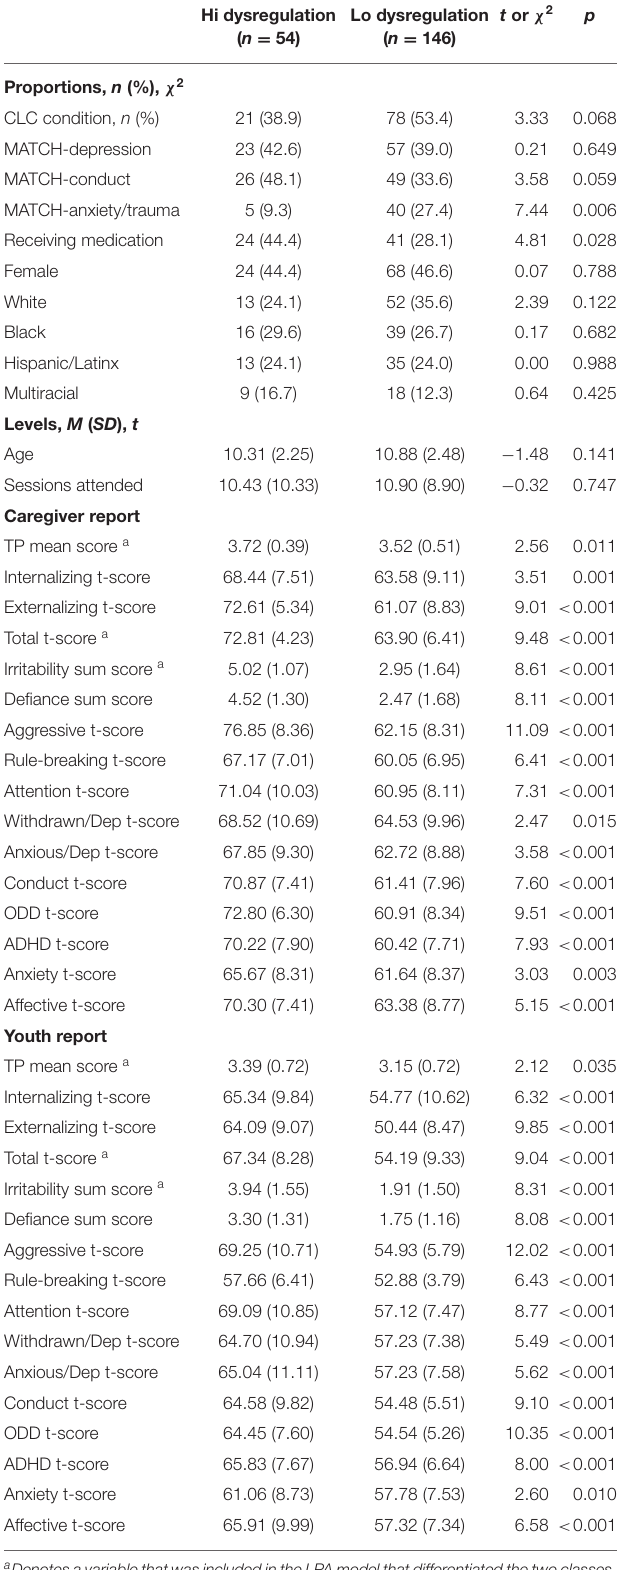
TABLE 1 | Characteristics of the high and low dysregulation